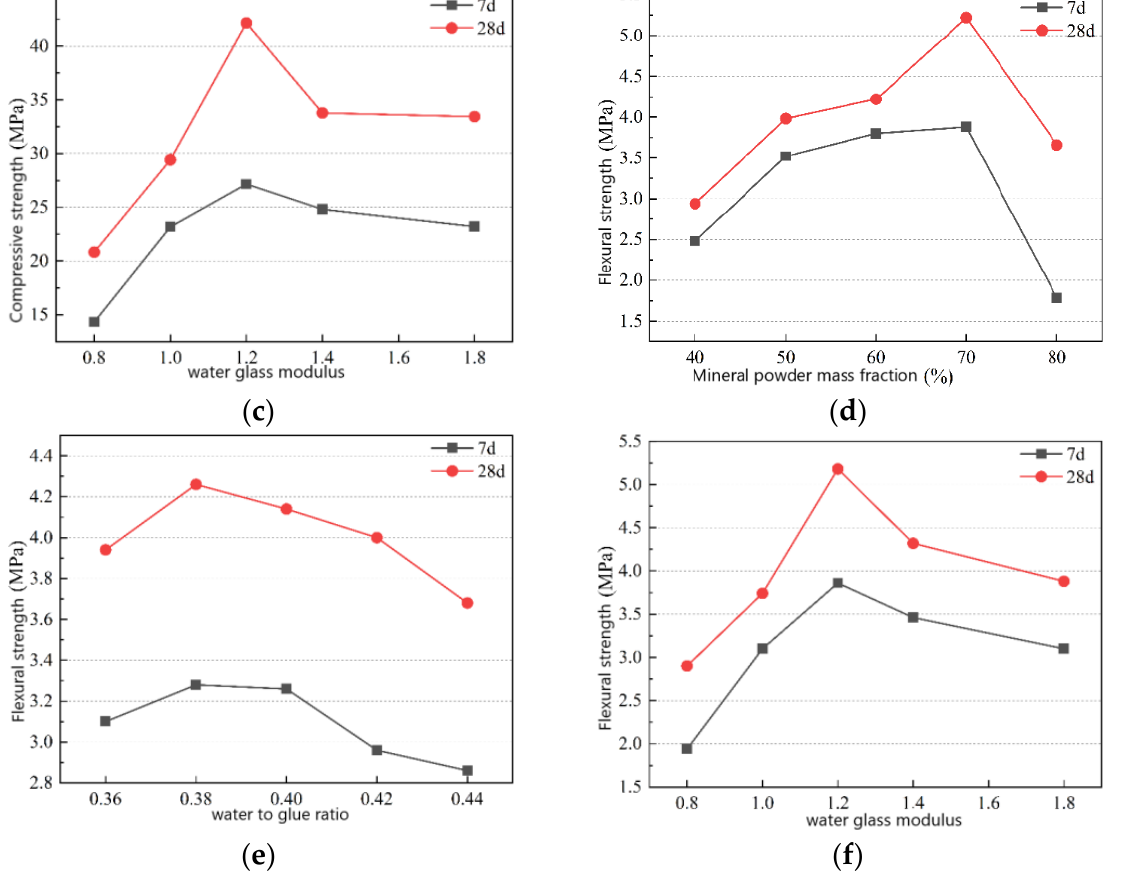
Figure 5. The variance analysis effect curve: ( a ): slag mass fraction versus compressive strength, ( b ): water-to-binder ratio versus compressive strength, ( c ): water glass modulus versus compressive strength, ( d ): slag mass fraction versus flexural strength, ( e ): water-to-binder ratio versus flexural strength, ( f ): water glass modulus versus flexural strength. Table 8. Variance analysis table of 7-day compressive strength results of orthogonal test.